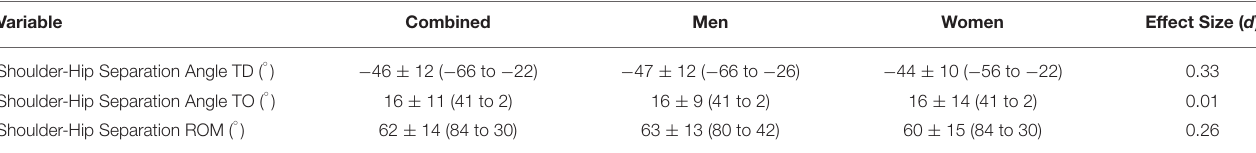
TABLE 2 | Variables representing the orientation of the shoulders and hips at touchdown (TD) and take-off (TO) of the final ground contact phase for men, women and the combined